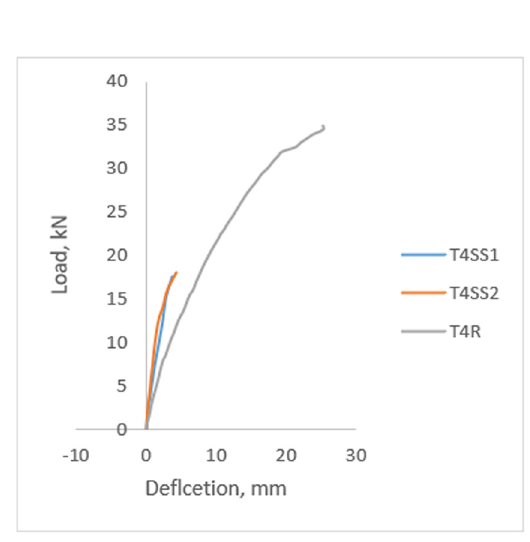
Figure 11: Slabs ’ load - de fl ection curves.